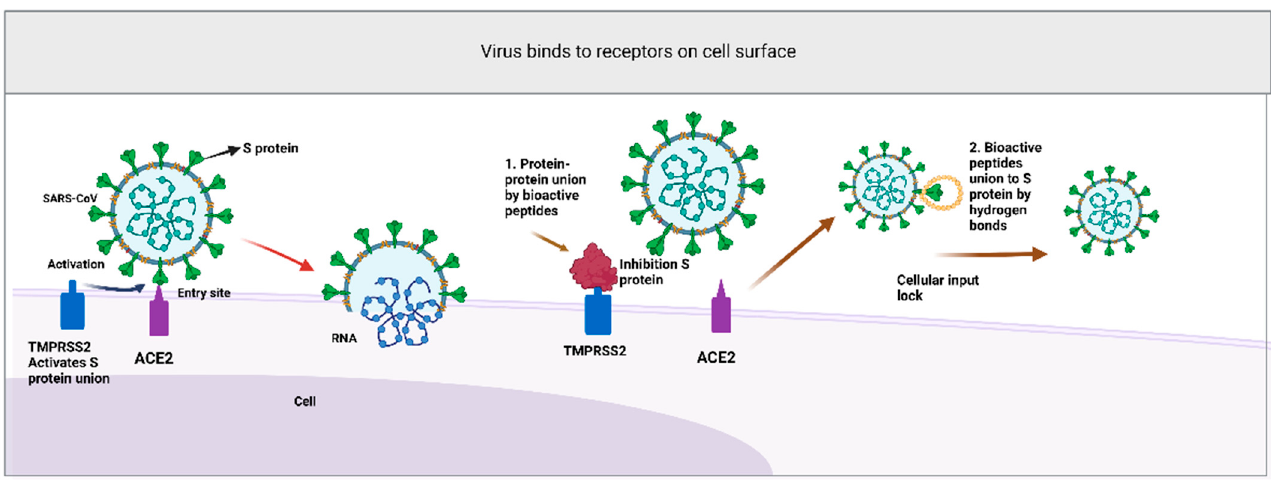
Figure 3. Peptide activity on SARS-CoV-2: (1) Inhibition of TMRPSS2 by bioactive peptides blocks priming of virus S proteins. (2) Inhibition of protein S by amino acid residues through hydrogen bonds prevents SARS-CoV-2 virus’ entry. Created with BioRender.com (accessed on 28 August 2022).